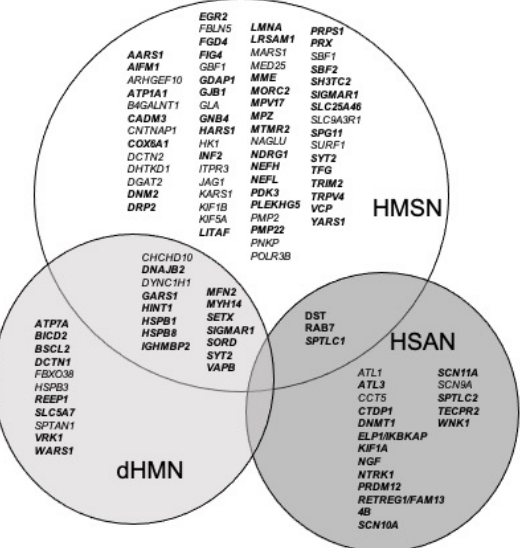
Figure 2. Venn Diagram of CMT gene subgroups. Bold genes represent the “definitive” classified genes.